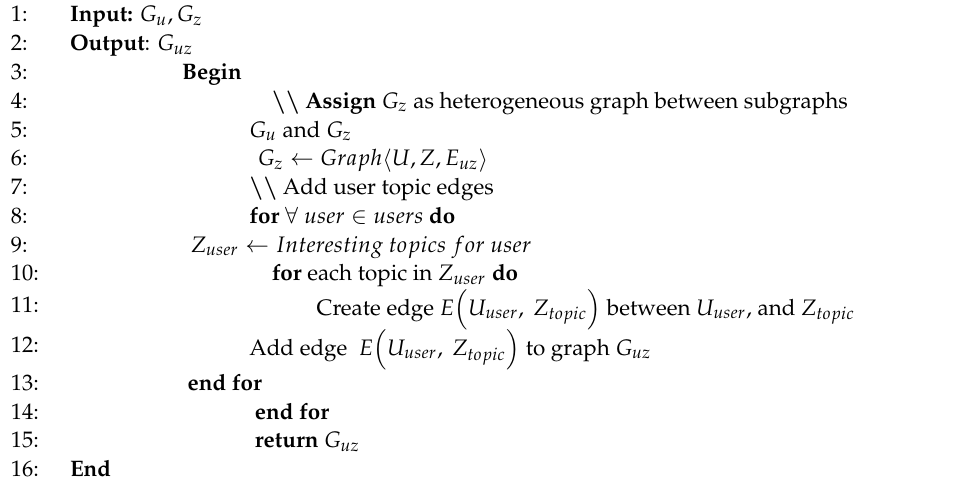
Algorithm 4 Generate Heterogeneous Graphs with two types of